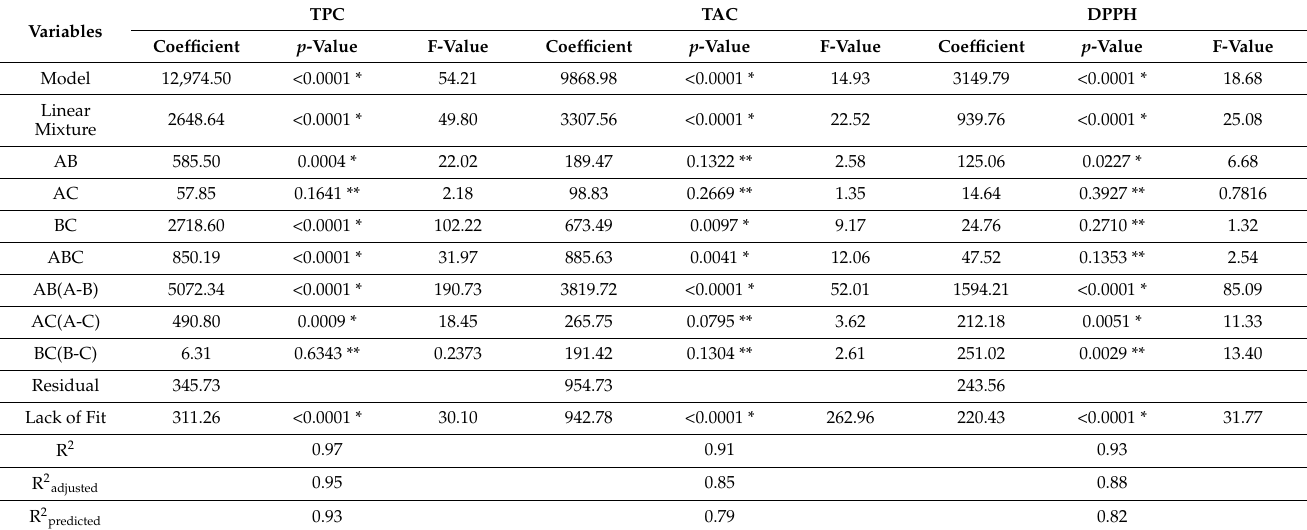
Table 2. Coefficients of each model and their level of significance determined by p